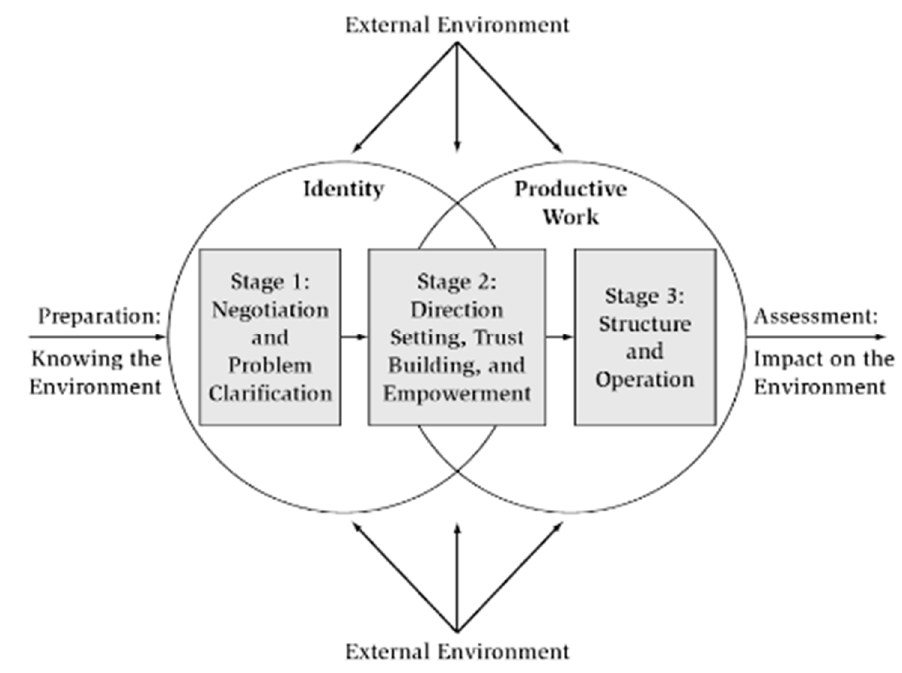
Figure 2. Framework for Partnerships for Community Development [28].